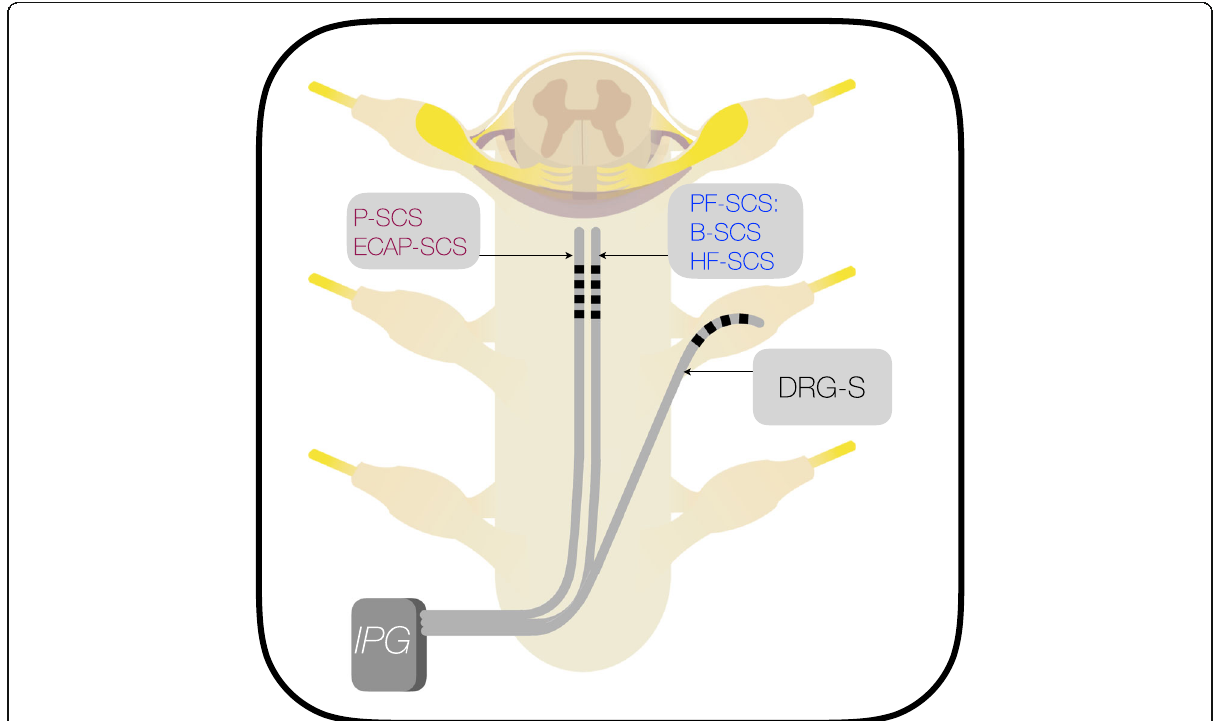
Fig. 1 Lead Placement in P-SCS and PF-SCS: Dorsal column stimulation with traditional P-SCS, B-SCS and HF-SCS are anatomically placed over the dorsal columns. DRG-S is placed within the targeted foramina overlying the dorsal root ganglion. In all cases SCS can result in orthodromic activation or antidromic activation. Acronyms: IPG (Implantable Pulse